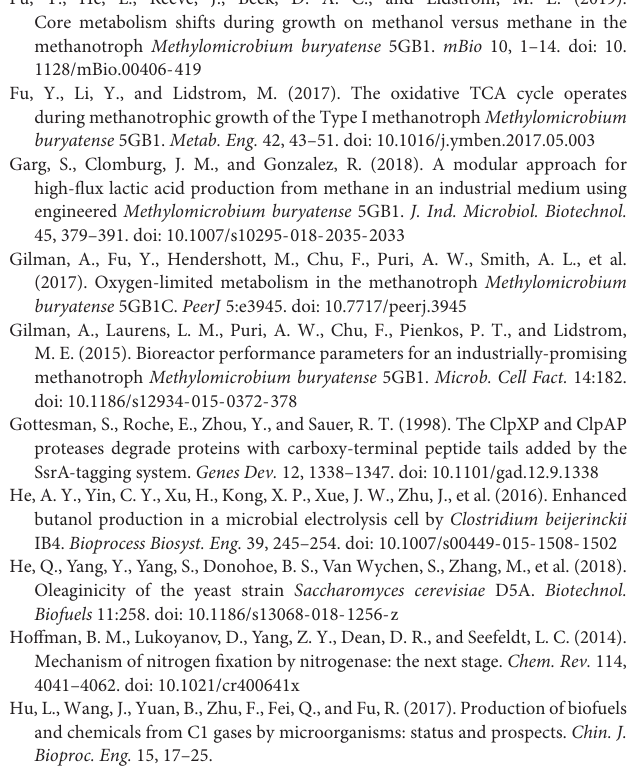
FIGURE S1 | Growth curve of M. buryatense 5GB1 under different CH 4 /O 2 ratios of 0.28, 0.58, 0.93, 1.31, and 5.24, respectively. FIGURE S2 | KEGG enrichment of differentially expressed genes (DEGs) in M. buryatense 5GB1 by comparing 0.93/#3 with 0.58/#2, 1.31/#4, and 5.24/#5. (a) Common up-regulated genes in KEGG pathway; (b) common down-regulated genes in KEGG pathway. TABLE S1 | Log 2 OD growth data for specific growth rate under different CH 4 /air ratio conditions. TABLE S2 | Differentially expressed genes of #3 (15% CH 4 in air) compared with #2 (10% CH 4 in air), #4 (20% CH 4 in air), and #5 (50% CH 4 in air). TABLE S3 | Differentially expressed genes of #3 (15% CH 4 in air) versus #2 (10% CH comparisons including 160 down-regulated and 177 up-regulated